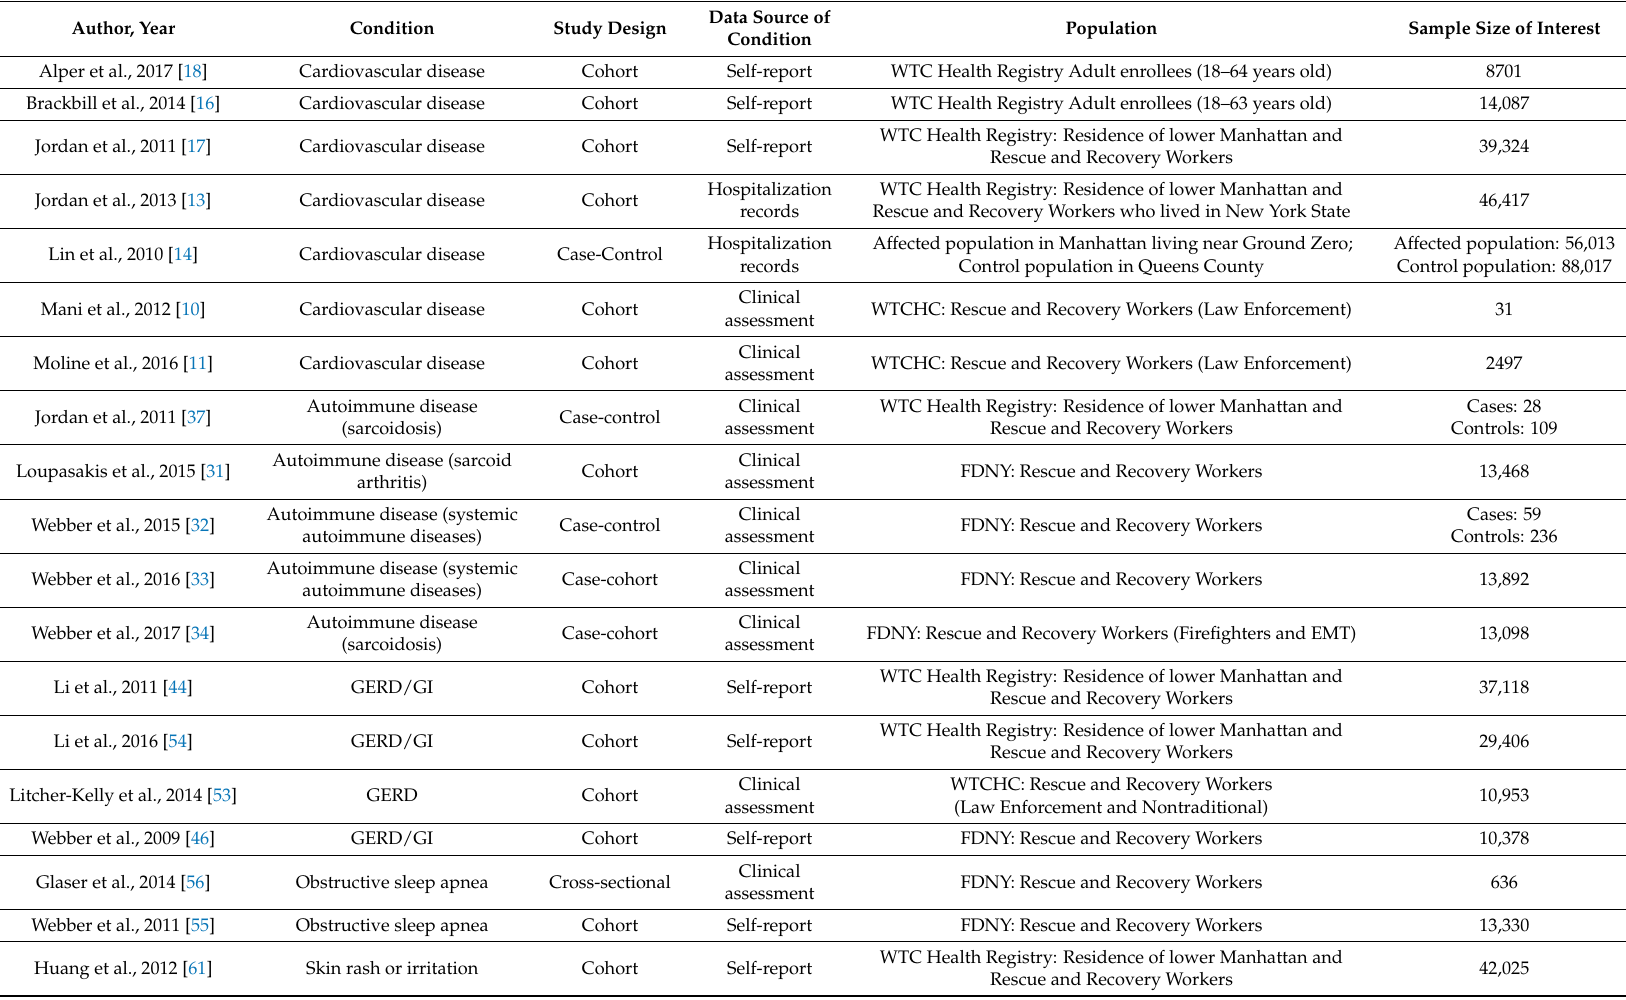
Table 1. Information about included